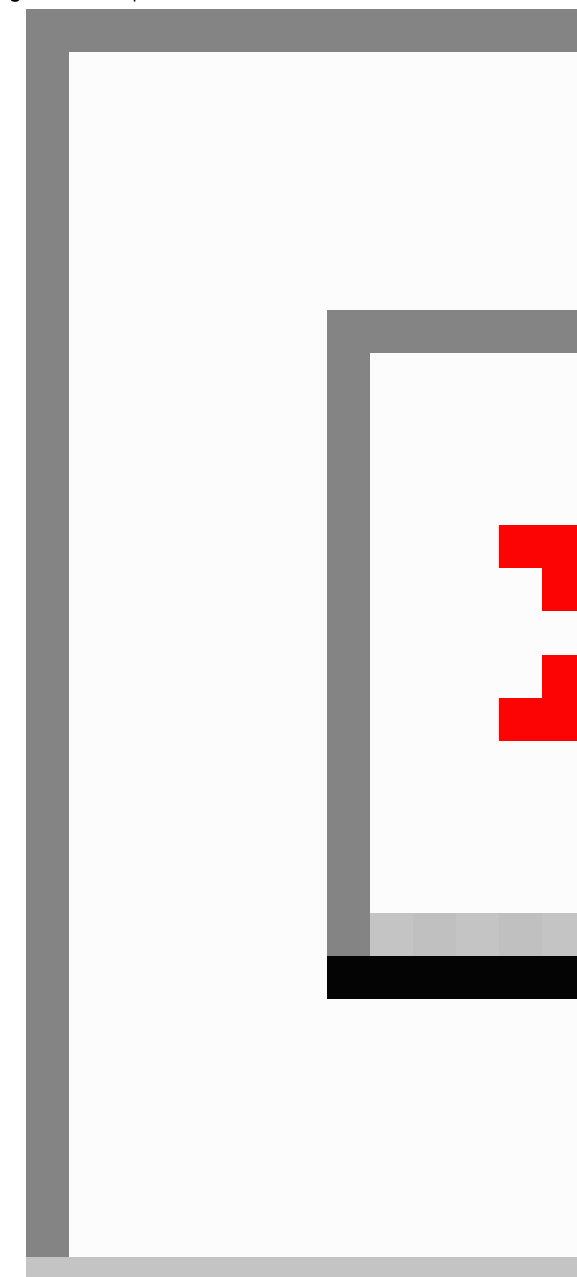
Figure 9. Example of form